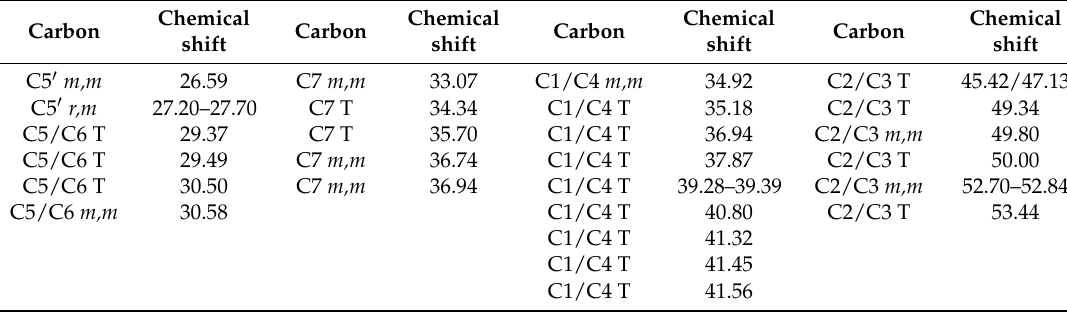
Figure 6. 13 C NMR spectrum of an E- co -N copolymer prepared with 2 containing 40.2 mol % of N [34]. Table 1. Assignments of 13 C NMR of spectra of random E- co -N copolymers with high N content. Carbon